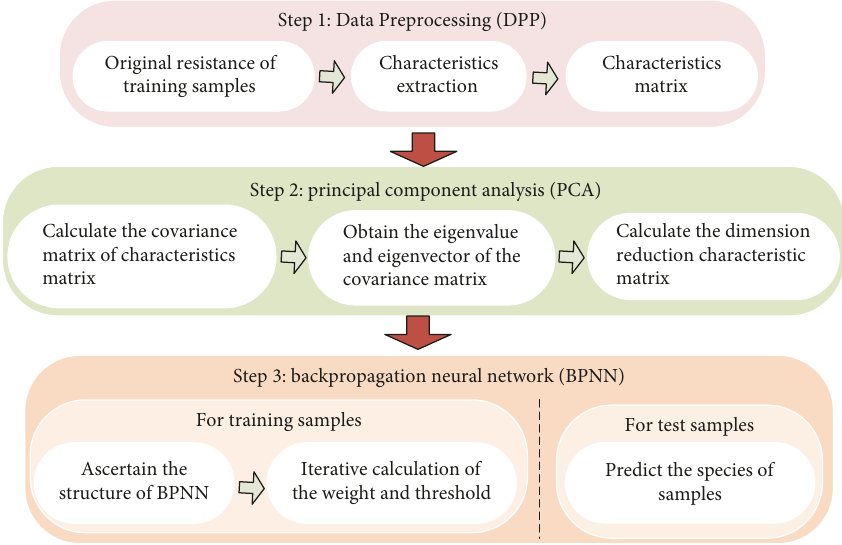
Figure 2: The process diagram of the discrimination algorithm.